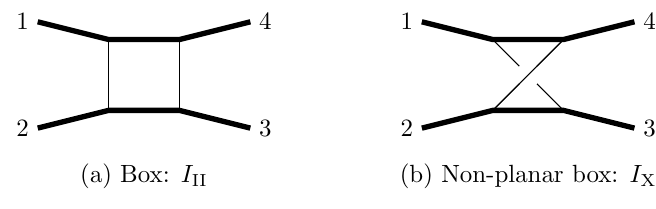
Figure 2. One-loop